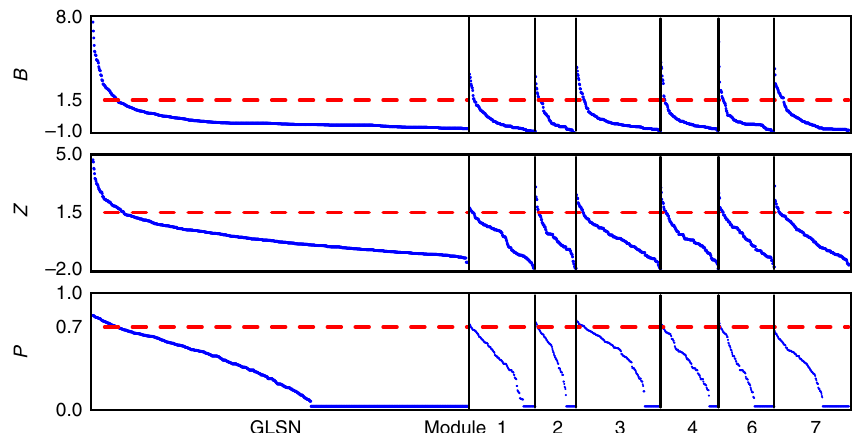
Fig. 4 Ports ’ outside-module degree ( B ), inside-module degree ( Z ), and participation coef fi cient ( P ). The rank-size distributions of B , Z , and P of ports are presented in linear plots. The large plots on the left correspond to the results for modular communities in the GLSN, and the small plots on the right the results for submodular communities in individual modules (except for module 5, the smallest one that cannot be further divided into submodules); plots are scaled according to the corresponding number of ports. Dash lines in the plots indicate corresponding threshold values of 1.5, 1.5, and 0.7 used to de fi ne gateway hubs, provincial hubs, and connector hubs,